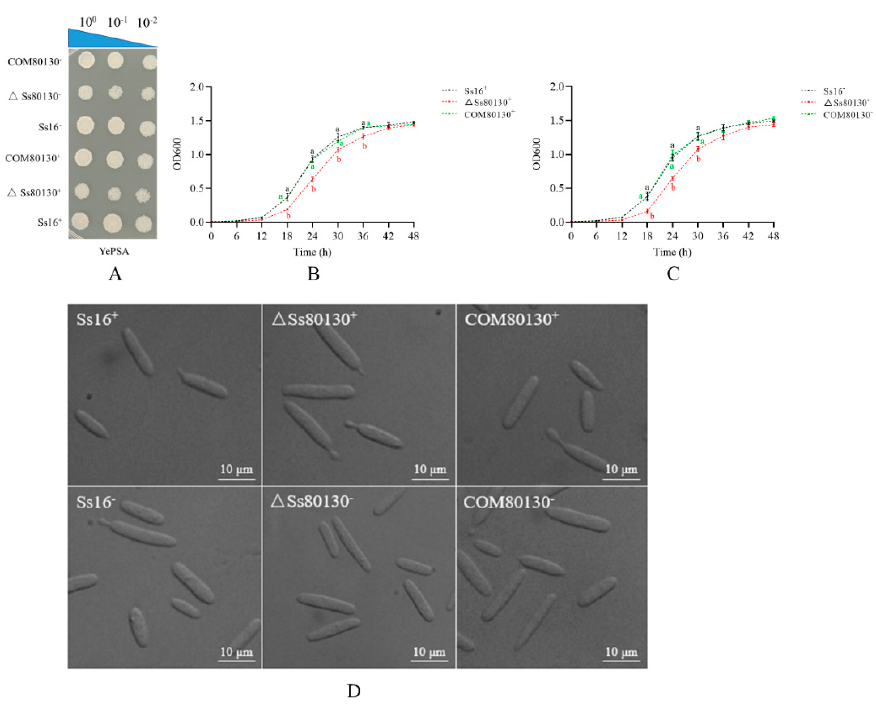
Figure 3. Effects of the SsCI80130 gene on the haploid phenotype of S. scitamineum . ( A ) Colony morphology. Haploid sporidial colonies of the wild type ( Ss16 + and Ss16 − ), knockout mutants ( Δ Ss80130 + and Δ Ss80130 − ), and complementary mutants ( COM80130 + and COM80130 − ) were spotted on YePSA plates and incubated at 28 °C for 48 h. ( B , C ) Haploid sporidial growth curve. Sporidia of the wild type, knockout mutants, and complementary mutants were inoculated to YePS liquid medium and cultured for 48 h. Each sample had three replicates. Bars indicate the standard error, and different lowercase letters represent a difference at the 0.05 level. ( D ) Microscopic images of sporidia of the wild type, knockout mutants, and complementary mutants (observed under a 100 × oil microscope after culturing in YePS liquid medium at 28 °C for 48 h).